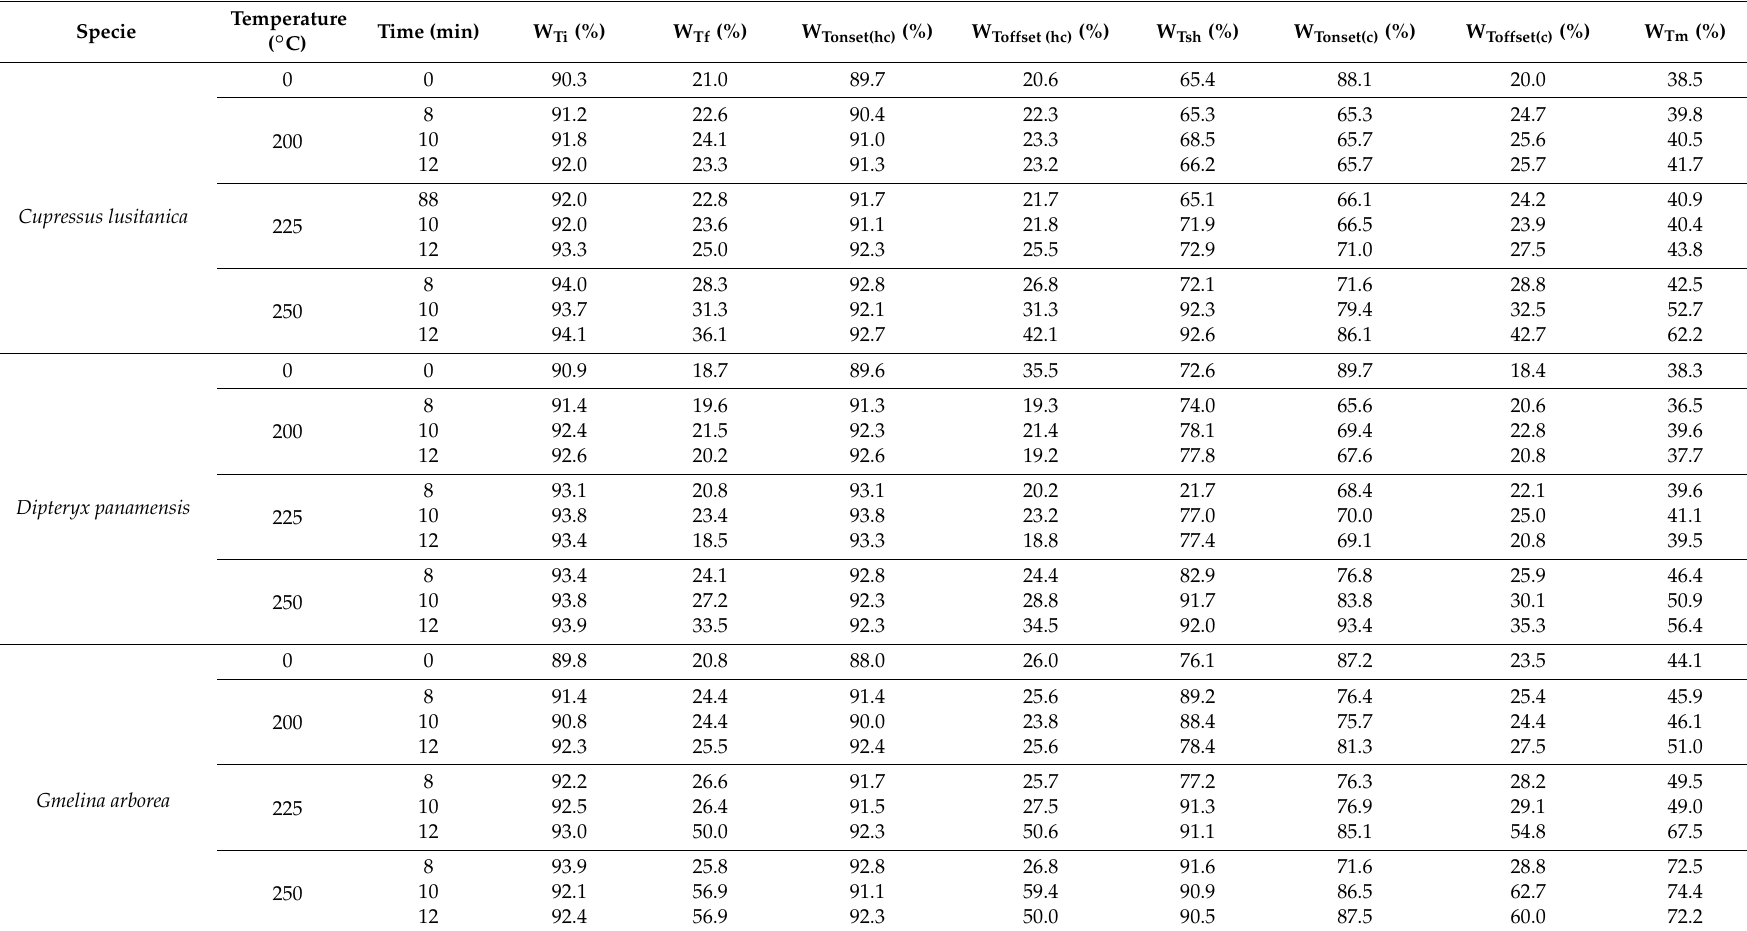
Table 3. TGA residual masses of the biomasses of five fast-growth plantation species in Costa Rica torrefied at different times and temperatures.